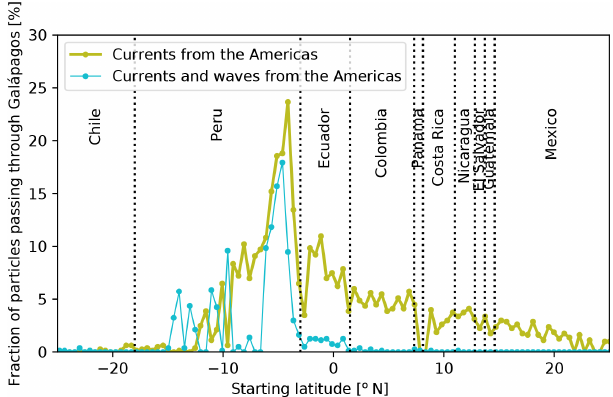
Figure 5. The fraction of particles that pass through the Galápa- gos box as a function of starting latitude for the “Fate from the South American coastline” scenario for particles carried by cur- rents only (yellow line) and for particles carried by the currents and waves (blue line). Dashed lines denote the approximate boundaries of different countries along the west-American coast. Most particles that pass through Galápagos start from northern Peru and southern